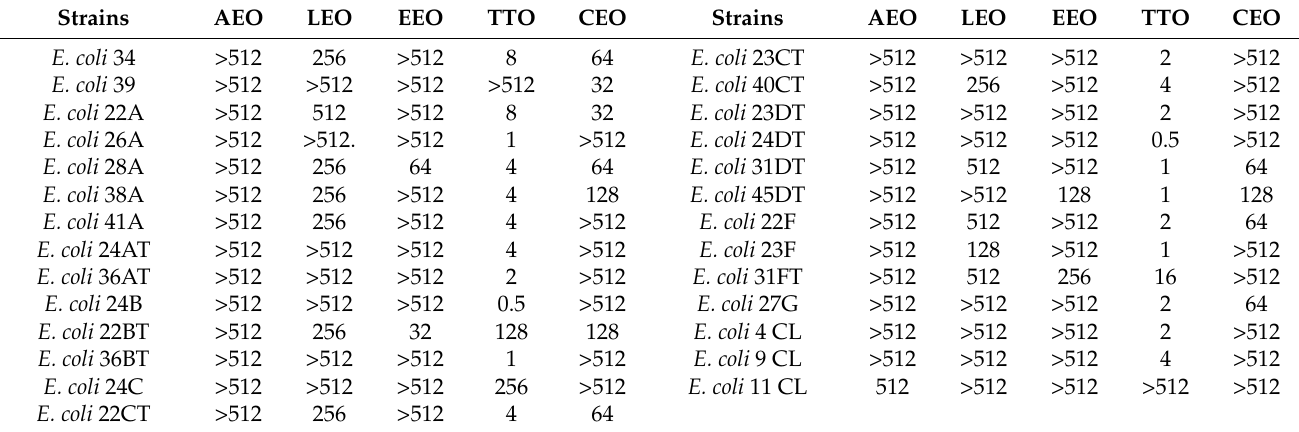
Table 4. Minimum inhibitory concentration (MIC) of EOs ( µ g/mL) against ESBL-producing E. coli strains.